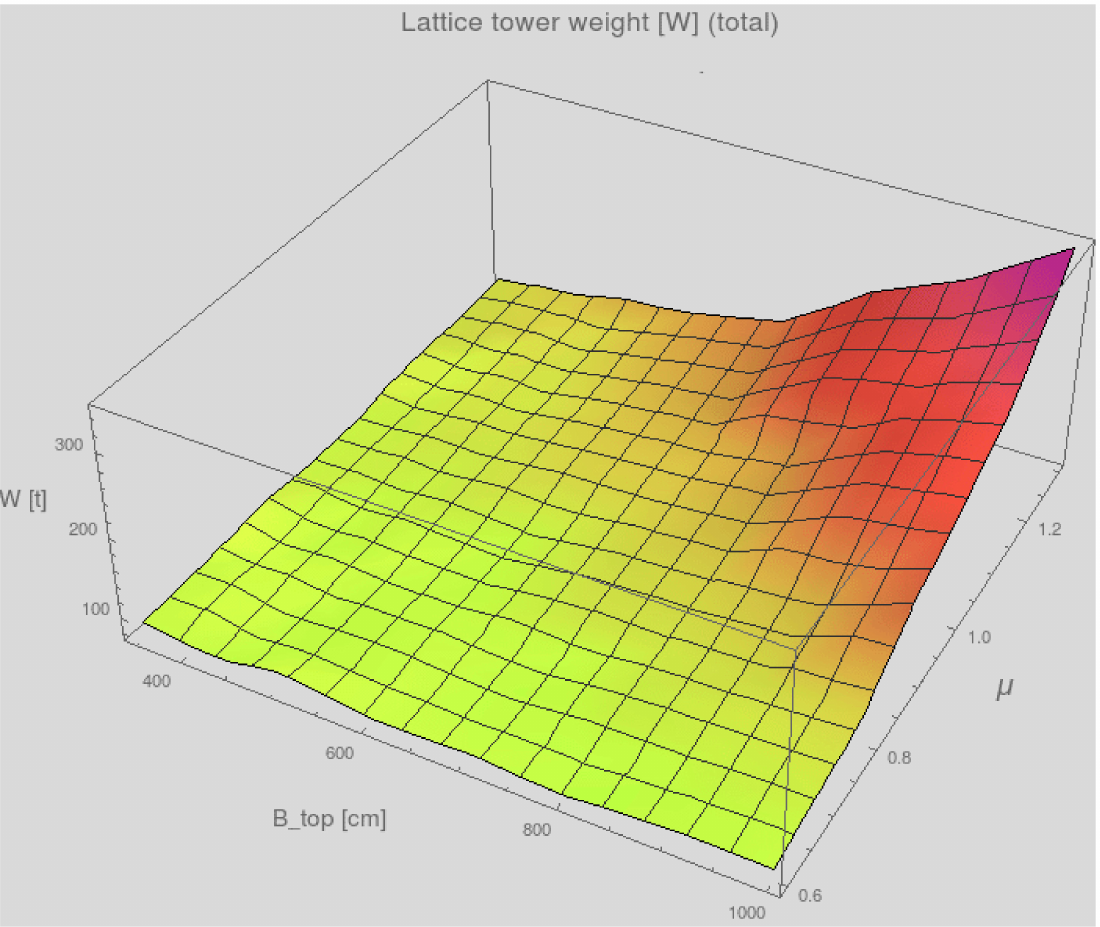
Figure 10. Total weight of tower cases in correlation with µ and Btop for the 76 m towers.